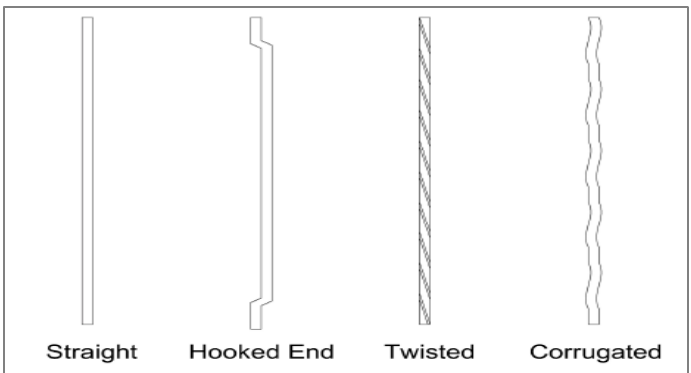
Figure 2. Shapes of fibers [23]. Table 1. Physical aspects of fibers.